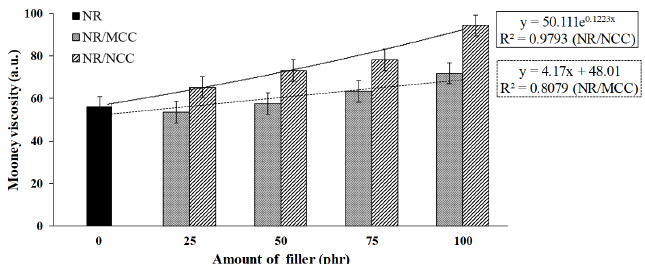
Figure 3. Mooney viscosity and linear relationship of natural rubber with either MCC or NCC at 25, 50, 75, and 100 phr.